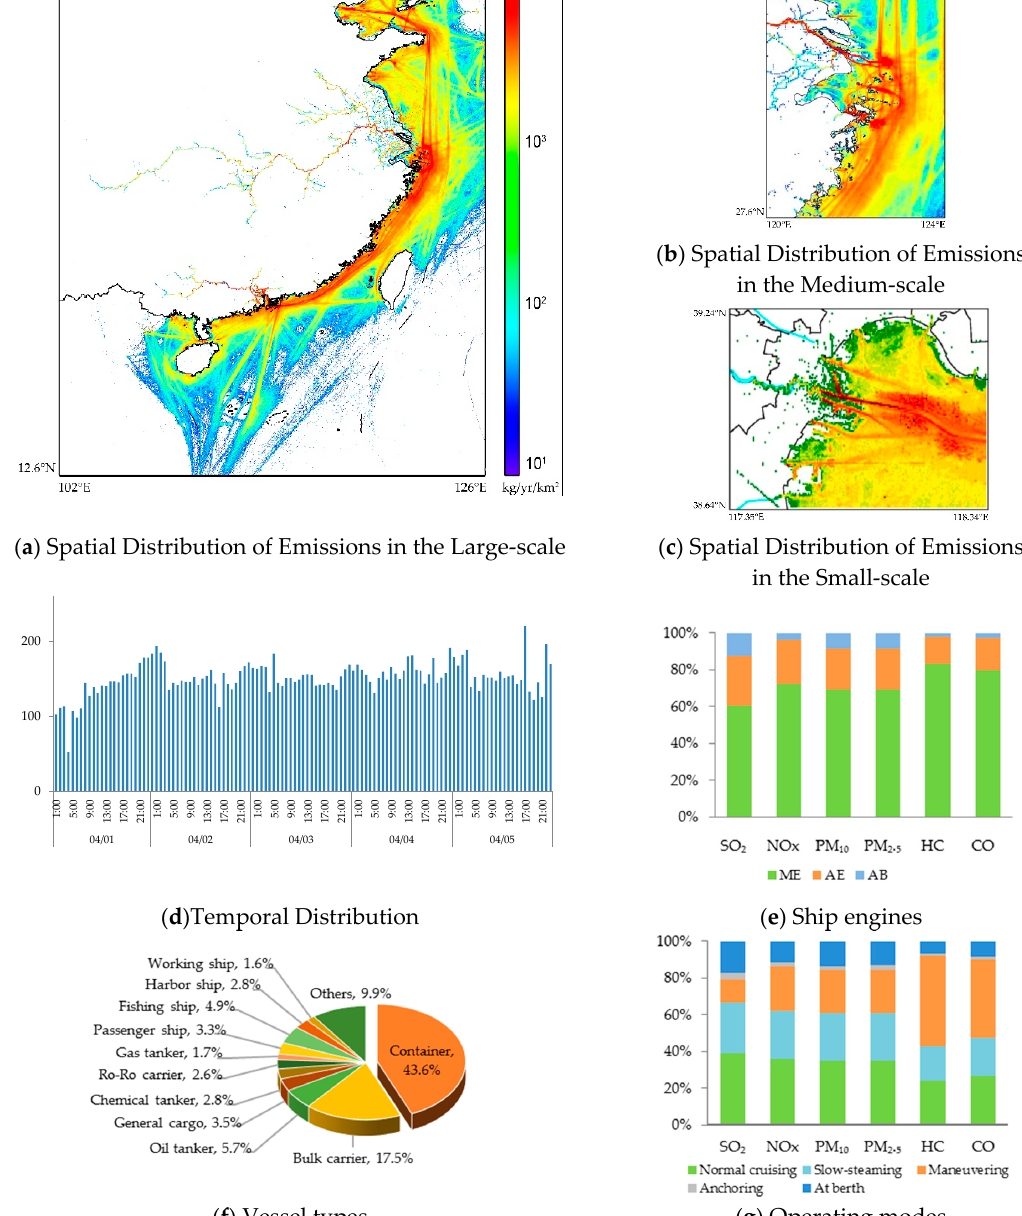
Figure 5. Diagrams of computed results by Method 1.